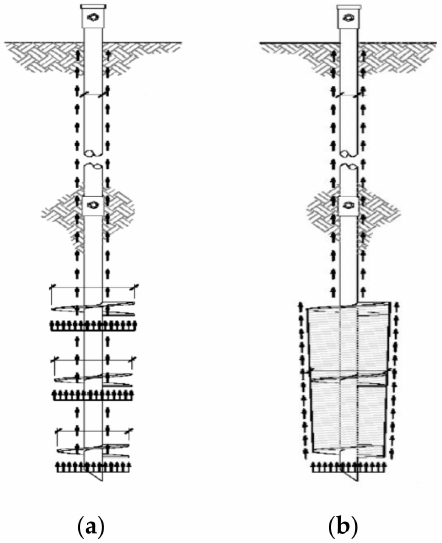
Figure 1. Schematic description of ( a ) Individual bearing method; ( b ) Cylindrical shear method (Perko